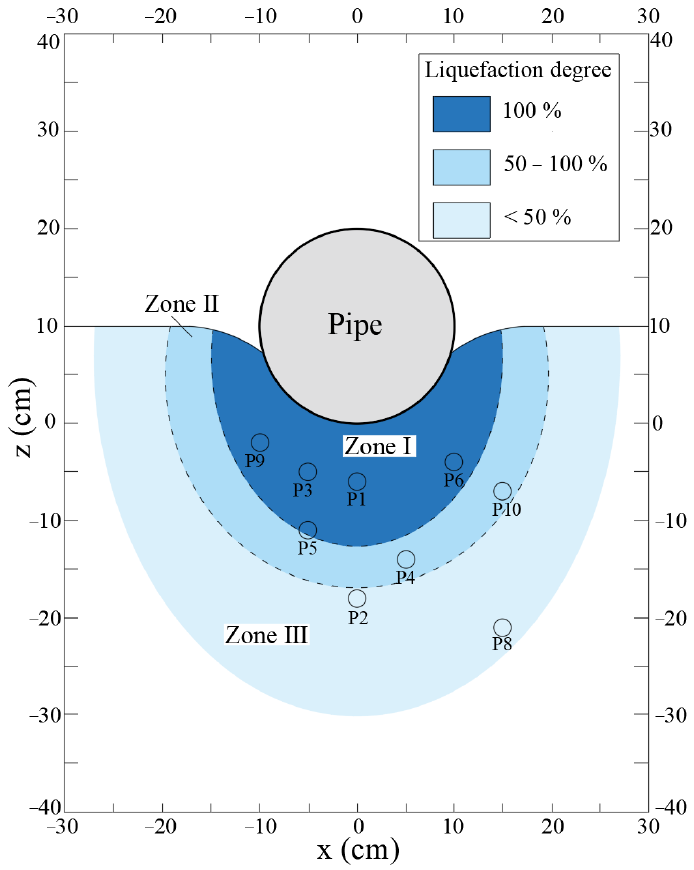
Figure 8. Contour of liquefaction degree around the model pipeline when the pipeline was loaded with the magnitude of periodic force F = 88.8 N in Test 8.